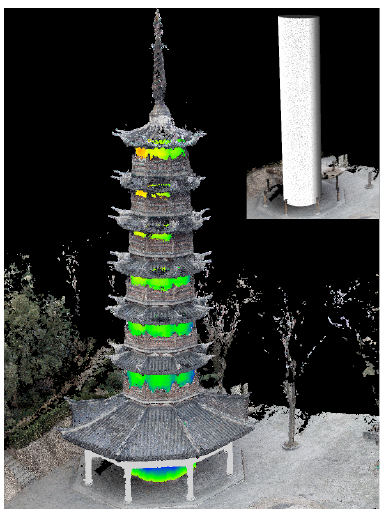
Figure 16. Analyzing the tilt of a pagoda by comparison with cylinder extruded from the circle sharing the same center with the octogonal ground floor